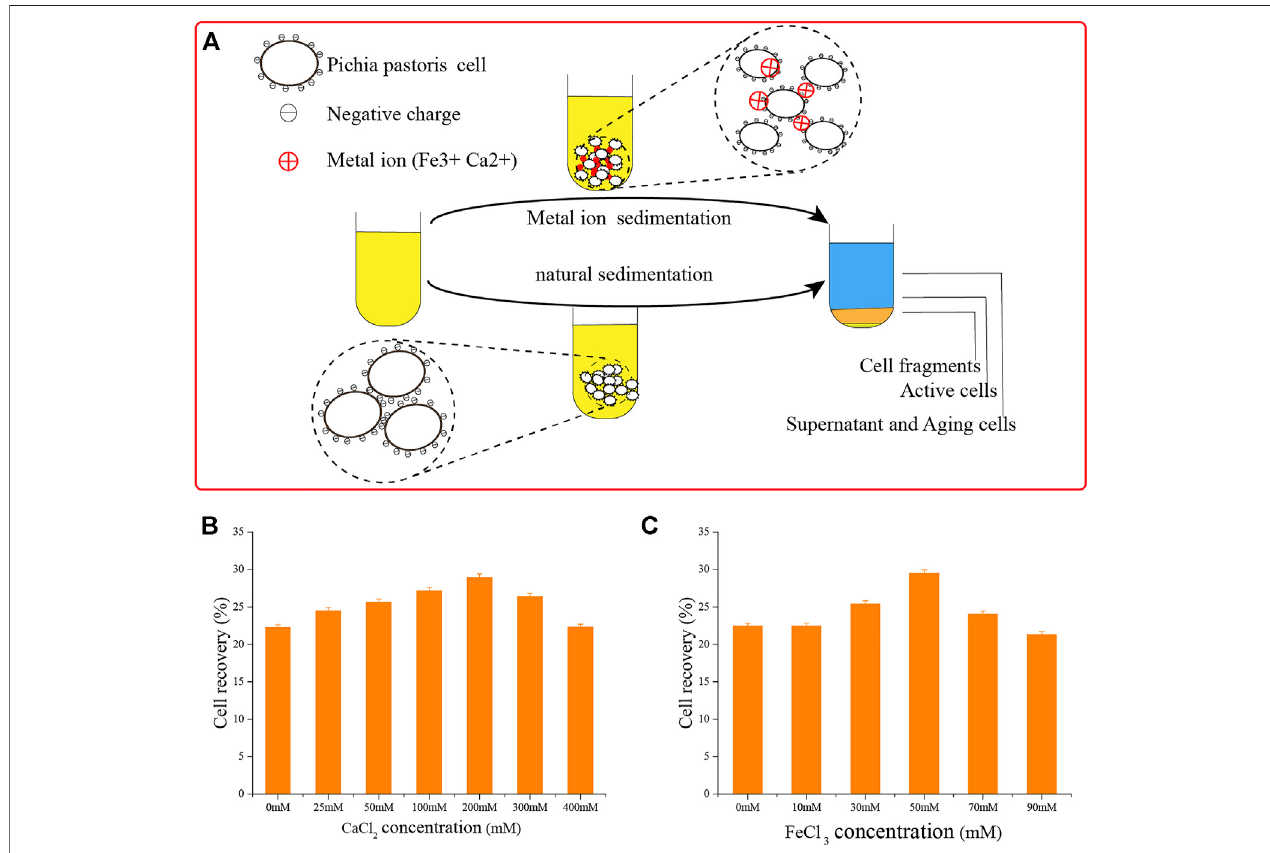
FIGURE 6 | Adding metal ions to accelerate cell sedimentation. (A) Schematic diagram of adding metal ions to accelerate cell sedimentation and natural cell sedimentation. (B) Adding Ca 2+ ions to accelerate cell sedimentation. (C) Adding Fe 3+ ions to accelerate cell sedimentation.